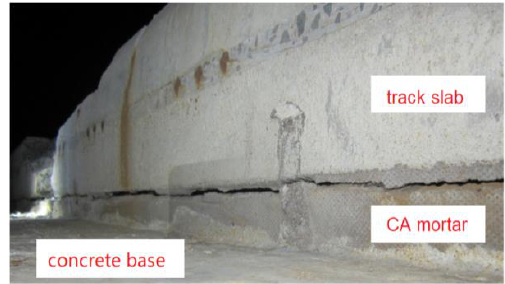
Figure 1. Interfacial cracks between layers.